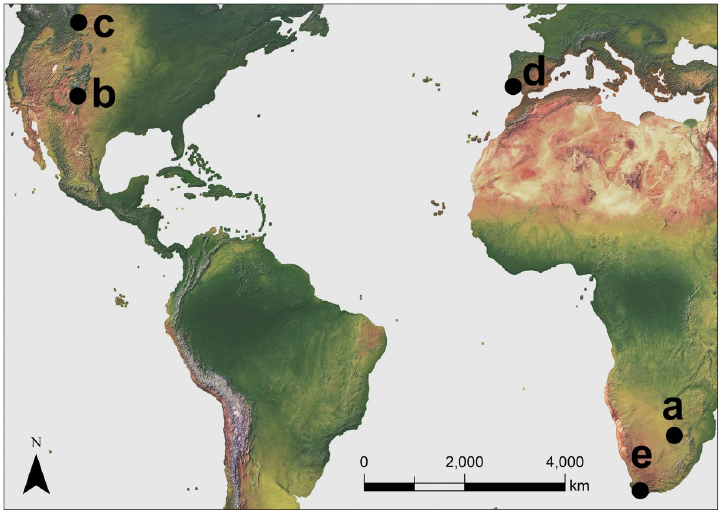
Fig 1. Locations of example species used in simulations of age truncation. (a) Enteromius motebensis , Marico River, South Africa; (b) Hybognathus amarus , Rio Grande, New Mexico, USA; (c) Hybognathus argyritis , Milk River, Alberta, Canada; (d) Iberochondrostoma lusitanicum , Torgal Rivulet, Portugal; (e) Pseudobarbus burchelli , Breede River, South Africa; Made with Natural Earth. Free vector and raster map data @ naturalearthdata.com.